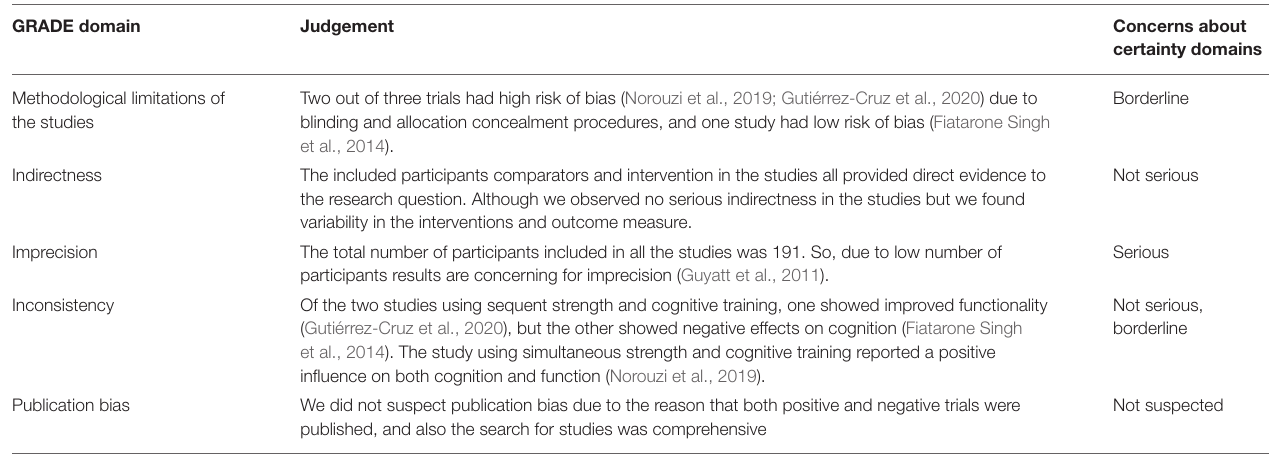
TABLE 3 | Rating the certainty in evidence.